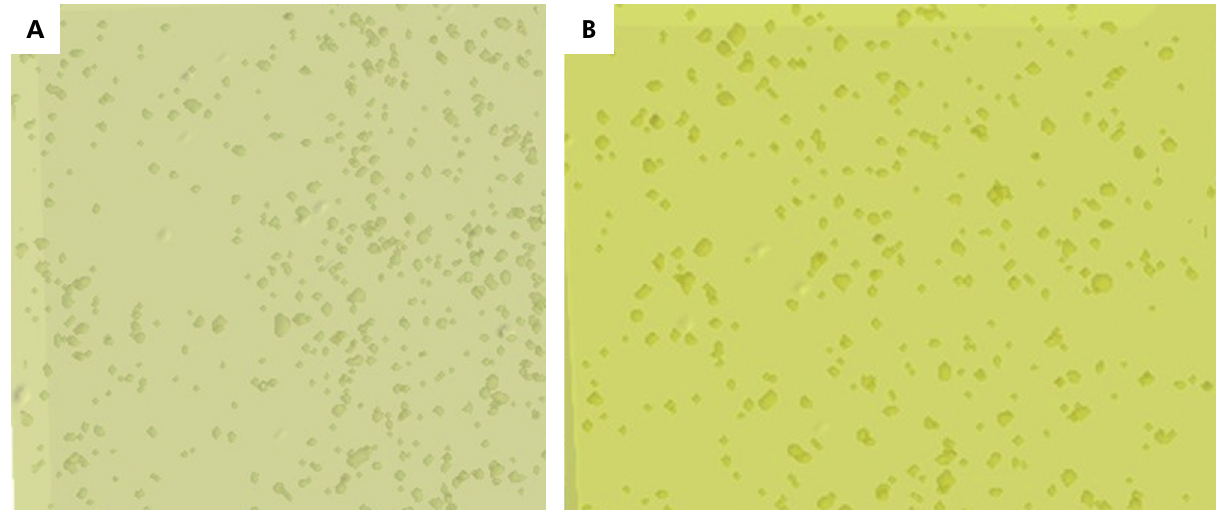
Figure 3. 3D reconstruction: A: IPS e.max CAD group using micro-CT scan; B: 3D reconstruction of Rosetta SM group using micro-CT scan